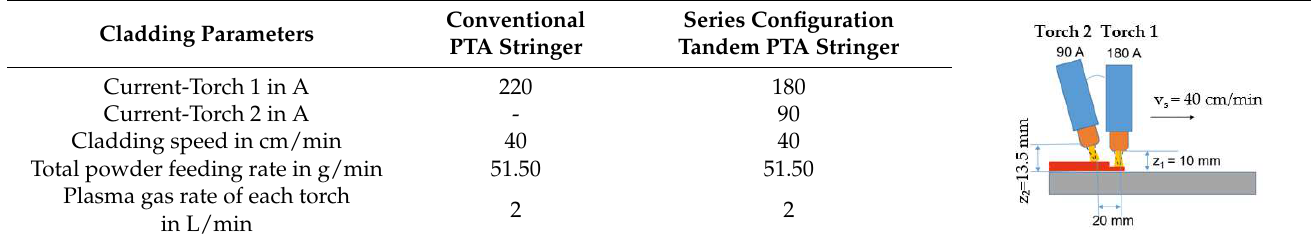
Table 4. Cladding parameters of conventional PTA and series configuration tandem PTA for multi- material coating.